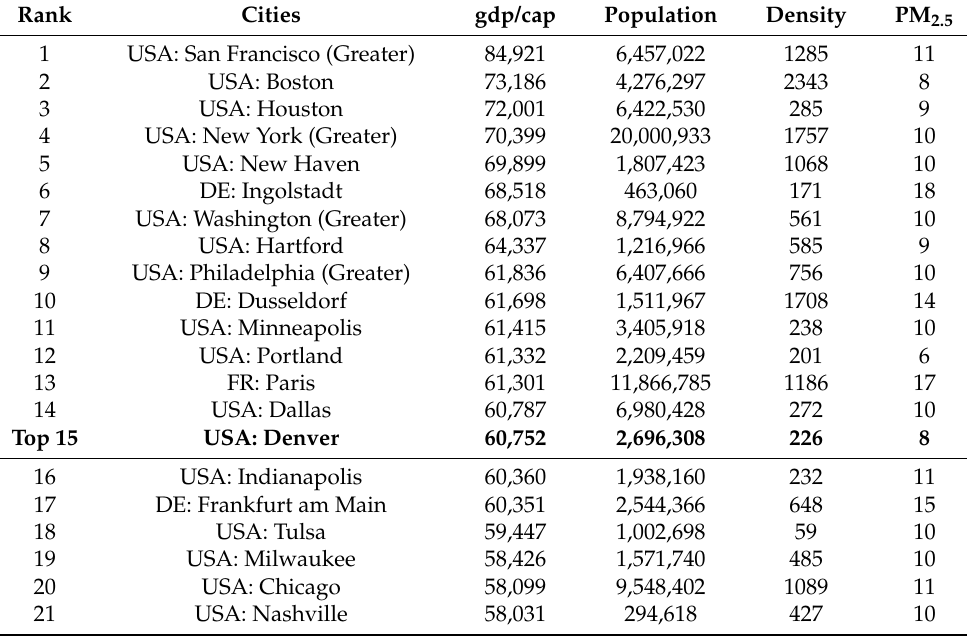
Table A1. Ranking of 254 cities into 5 subgroups by income per